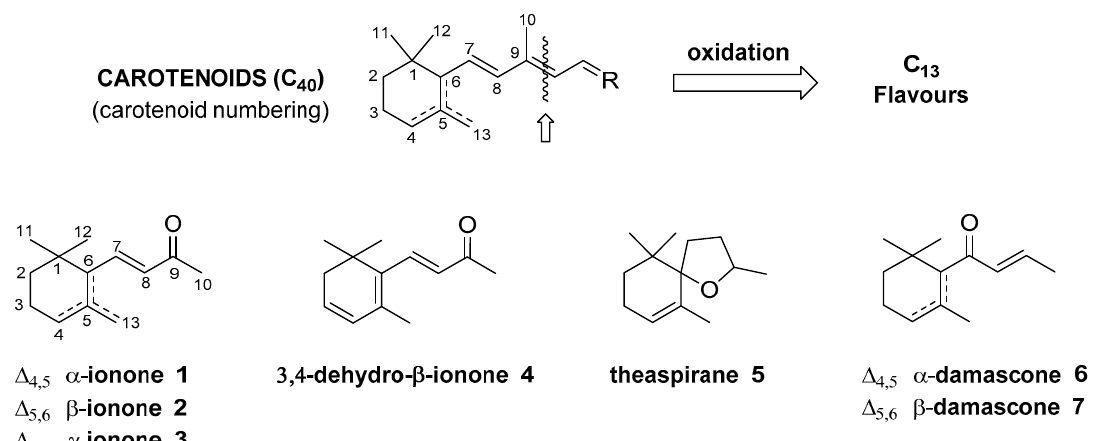
Figure 1. The formation of apocarotenoids through degradation of carotenoids and the seven C 13 apocarotenoids (compounds 1 – 7 ) selected as substrates for the fungal biotransformation investigated in the present study.